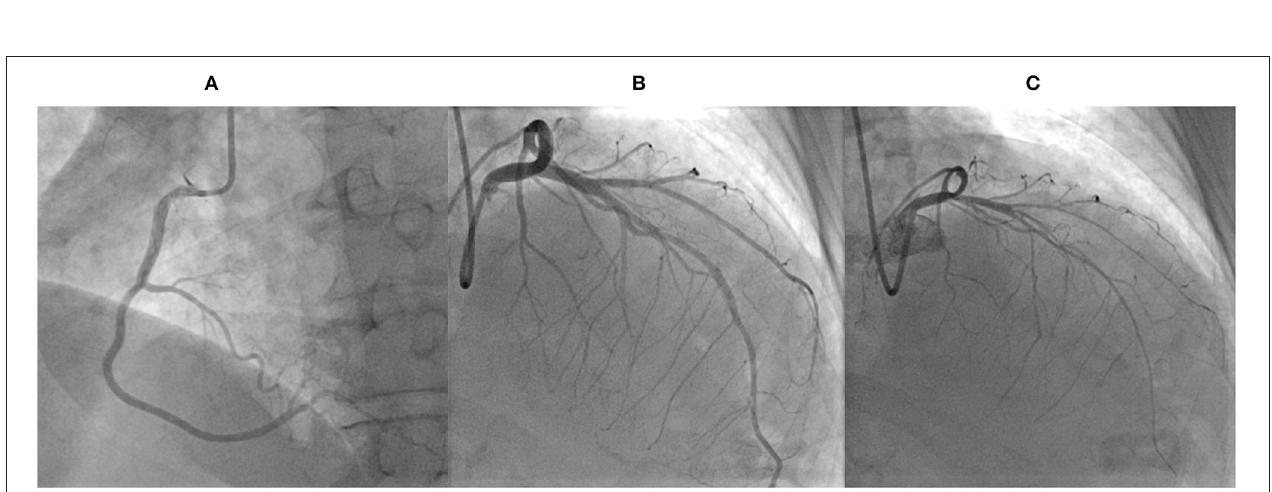
FIGURE 2 | Transthoracic echocardiogram obtained at admission. (A) Parasternal long axis view showing left ventricle dilation and dilation of aortic root and ascending aorta. (B) Apical four-chamber view revealing left ventricle dilation with reduced ejection fraction due to apical and midventricular akinesia in the septal and lateral walls, and normal right ventricular function. (C) Severe aortic regurgitation in (five-chamber view). (D) Apical two-chamber view showing akinesia of the midventricular and apical segments of the anterior and inferior left ventricular walls.